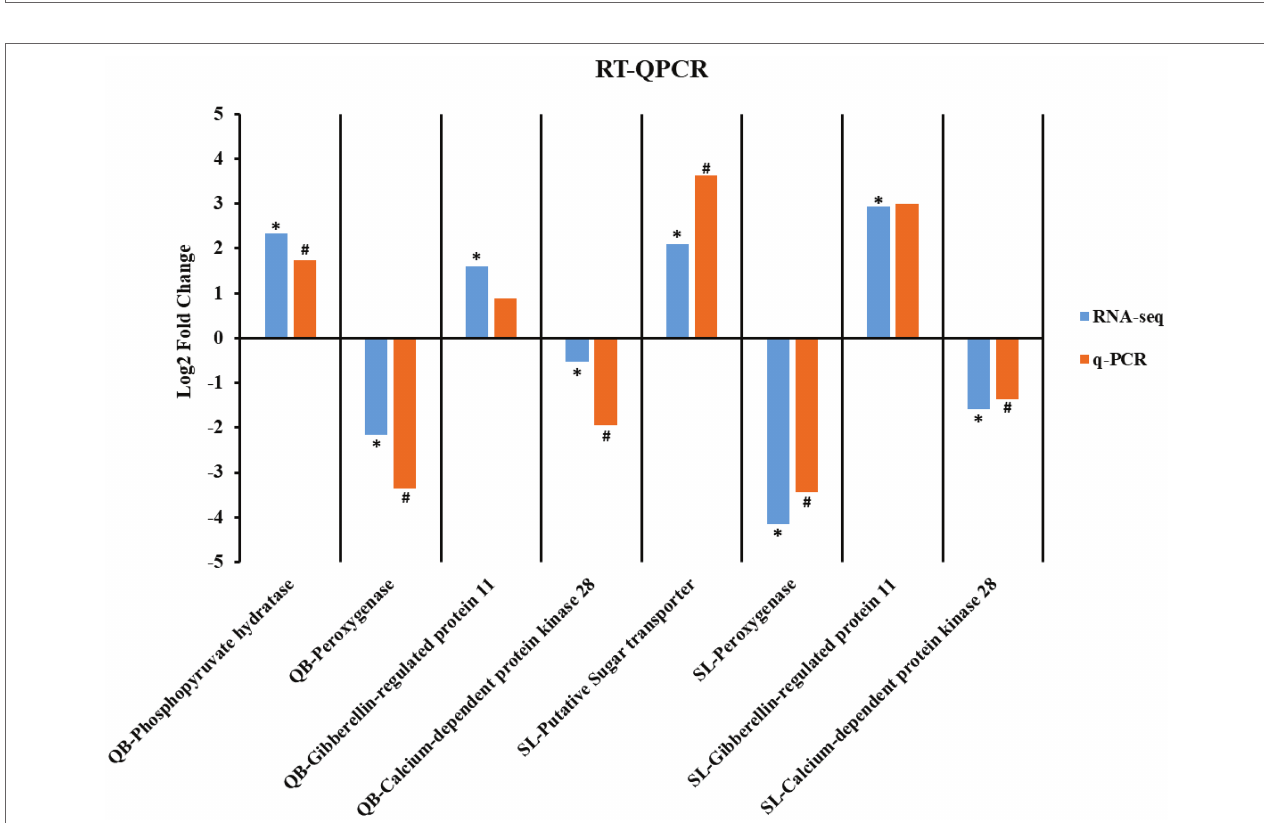
FIGURE 6 | Comparison of gene expression trend based on RNA-seq and RT-qPCR. * and # indicate a significant difference in expression between seed in the mature stage and the germination stage in the RNA-seq and RT-qPCR,